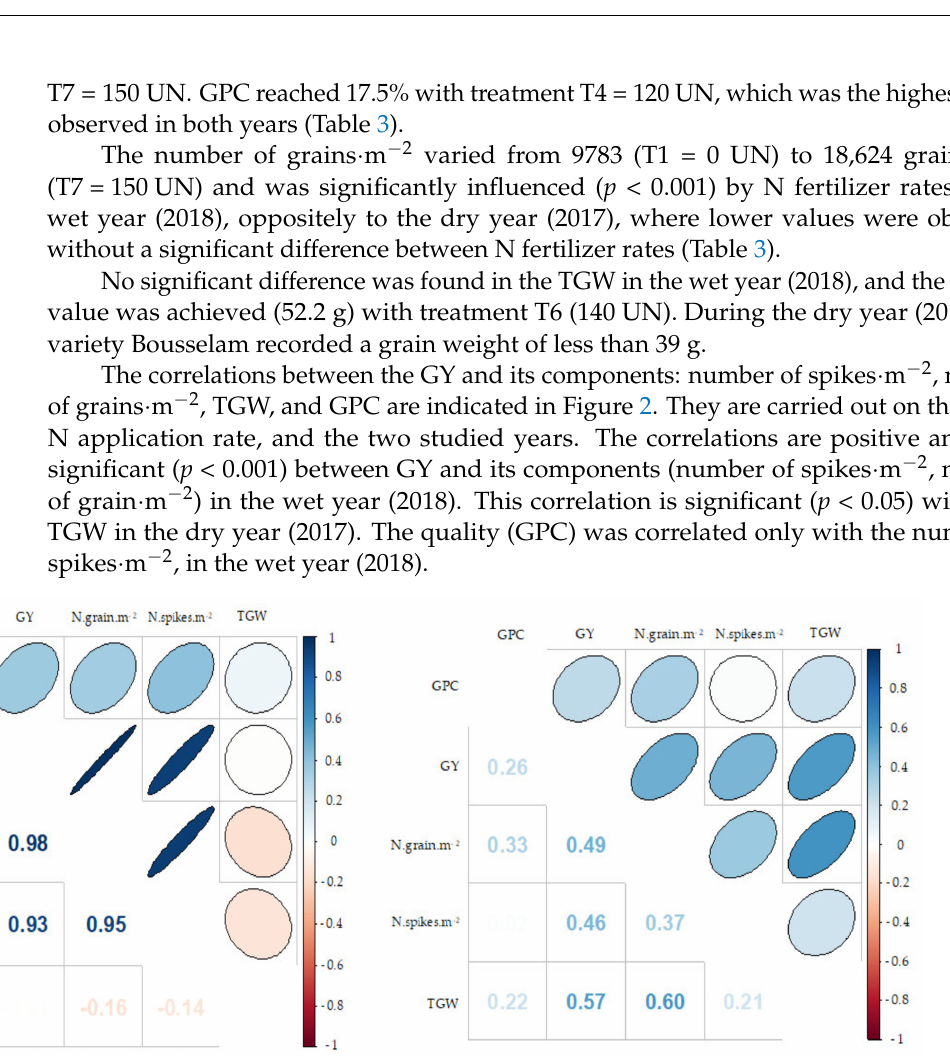
Figure 2. Correlation matrix of the grain yield (GY) and their components: Number of spikes · m − 2 (N · spikes · m − 2 ), number of grain · m − 2 (Ngrain · m − 2 ), TGW, and the GPC, for the two years ( left : wet year, right : dry